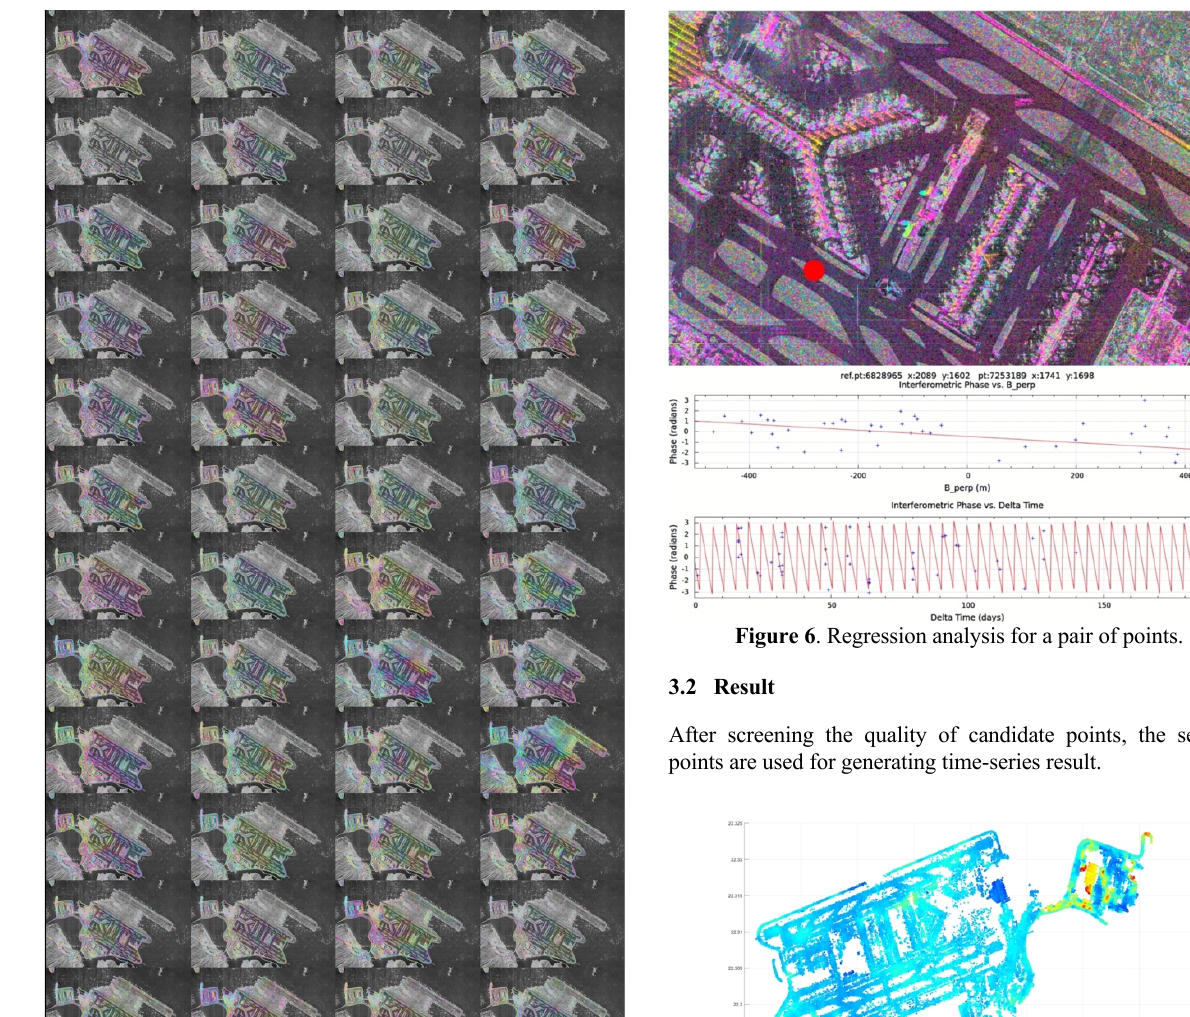
Figure 5 . Interferograms of the PS candidate points.